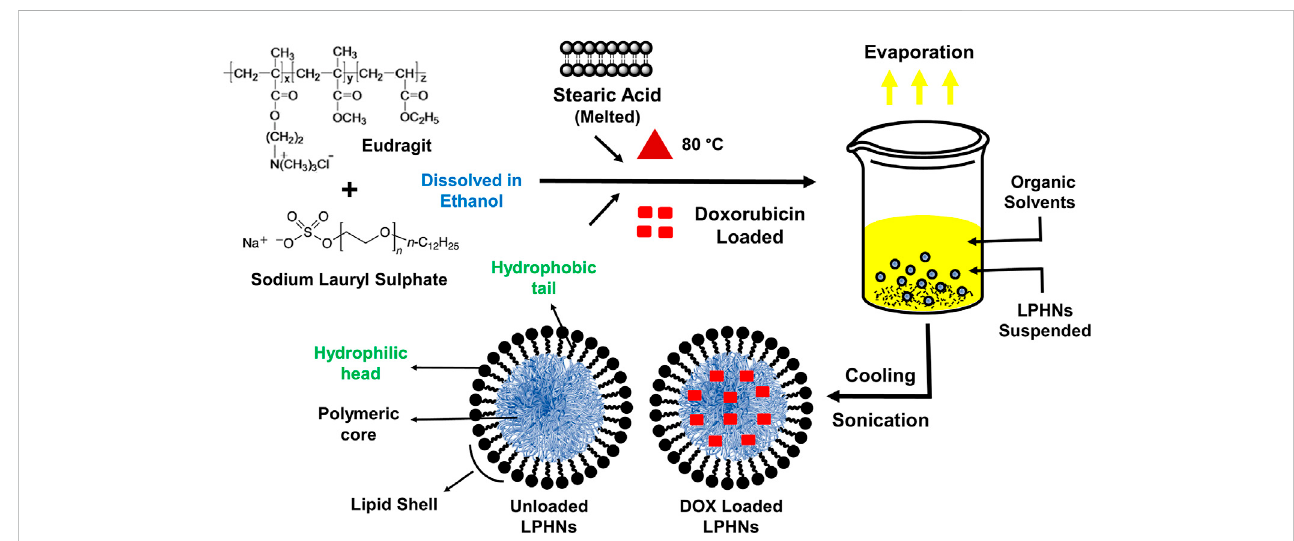
Schematic illustrations showing the preparation of LPHNs (unloaded) and DOX-LPHNs (loaded)